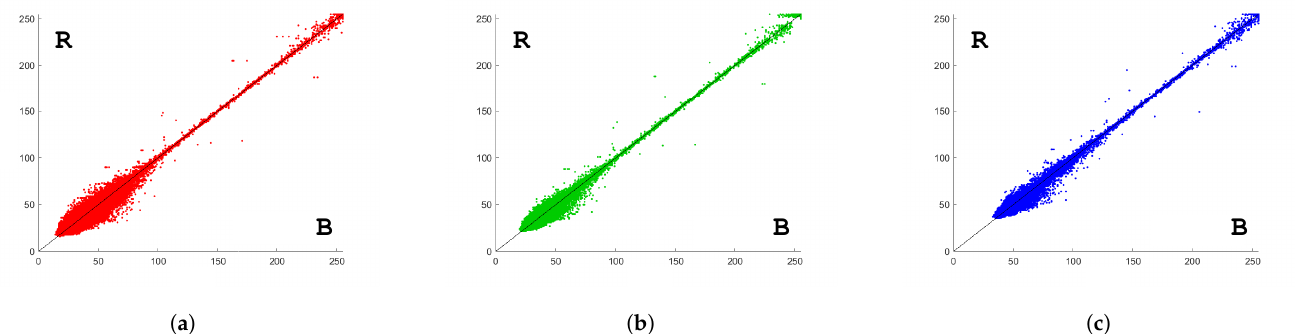
Figure 12. RGB self-validation test—ED based reconstruction; B = Base intensity values, R = Reconstructed intensity values. ( a ) scatter plot of red values; ( b ) scatter plot of green values; ( c ) scatter plot of blue values. Band set: Near-infrared, Red, Green (NRG)—segmentation parameters α = 500, λ =